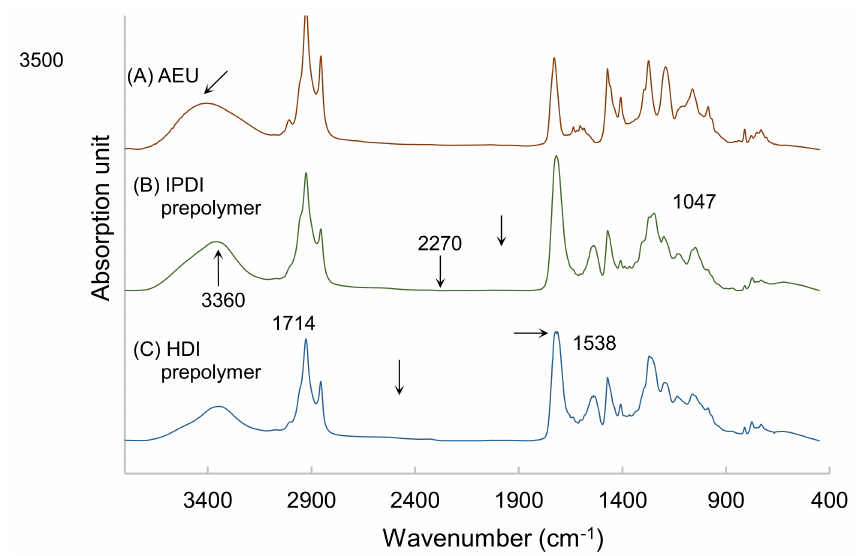
Figure 6. FTIR spectra of ( A ) AEU, ( B ) IPDI-containing prepolymer, and ( C ) HDI-containing